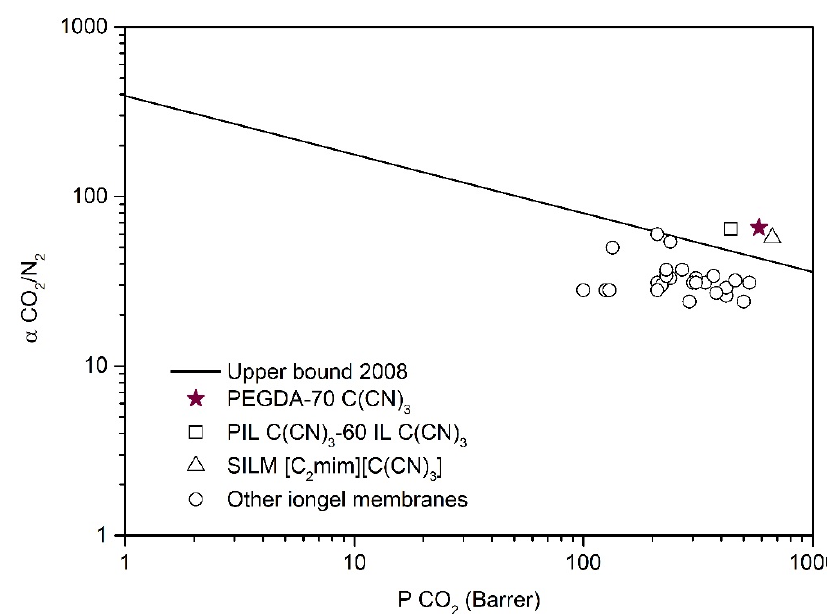
Figure 8. CO 2 / N 2 iongel ideal selectivity as a functional of CO 2 permeability. Data are plotted on a log – log scale and the upper bound is adapted from Robeson [55]. The literature values are illustrated for comparison purposes and were taken from: ( □ ) [12] , ( ∆ ) [37] and (o) [20,22,34–36] .